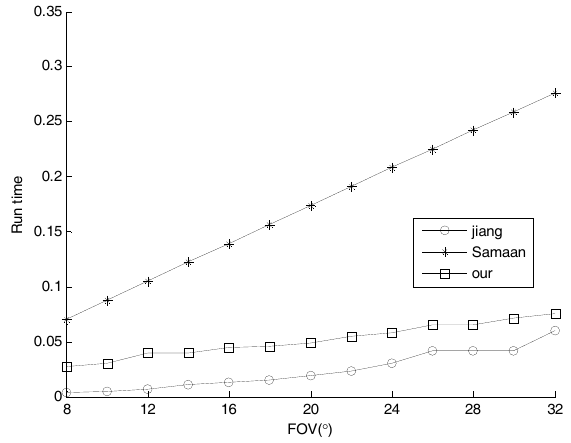
Figure 18. Time to simulate the reference star image versus N.